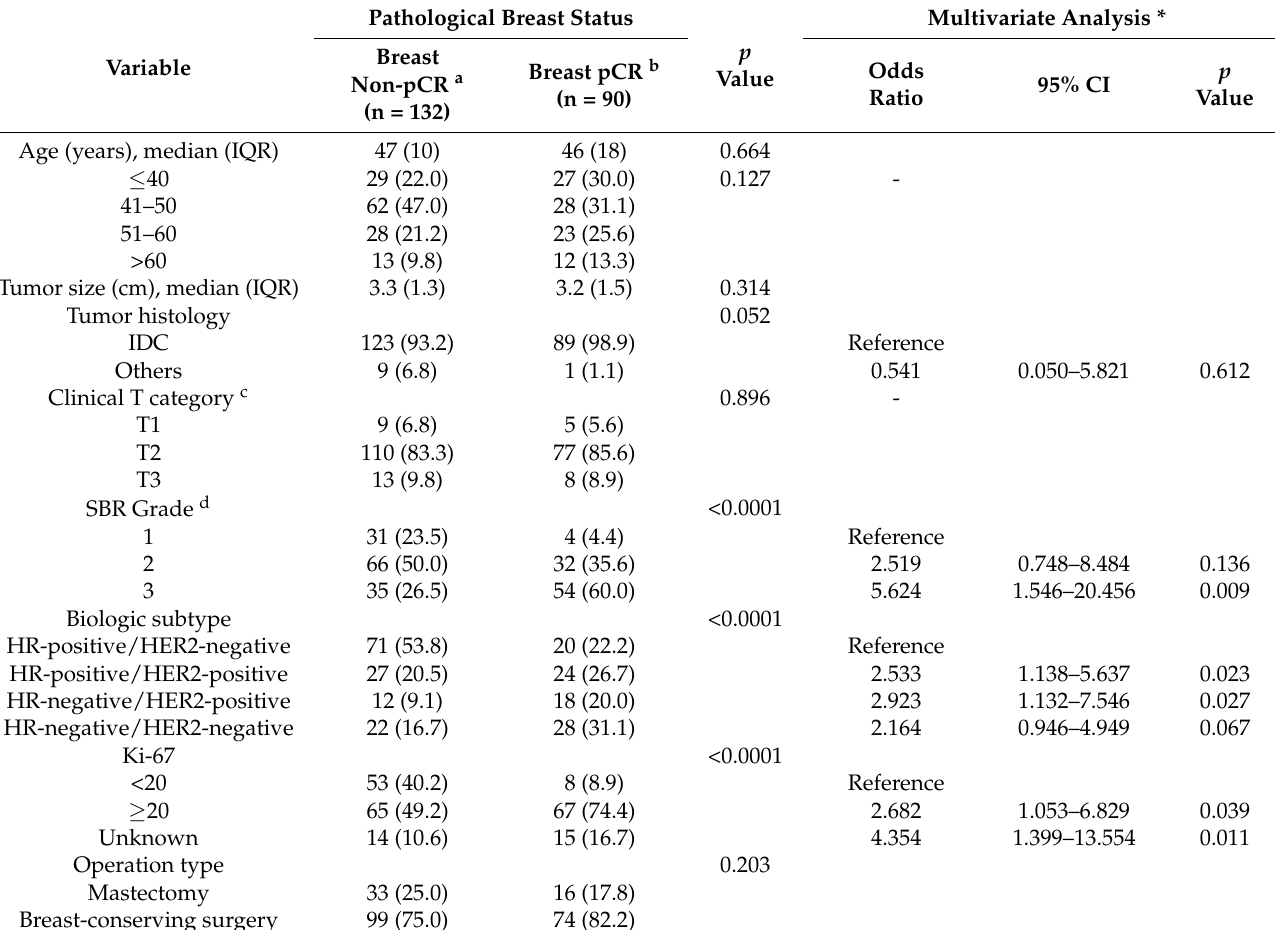
Table 3. Univariate and multivariate analysis of factors associated with breast pathologic complete response in the whole patient cohort after